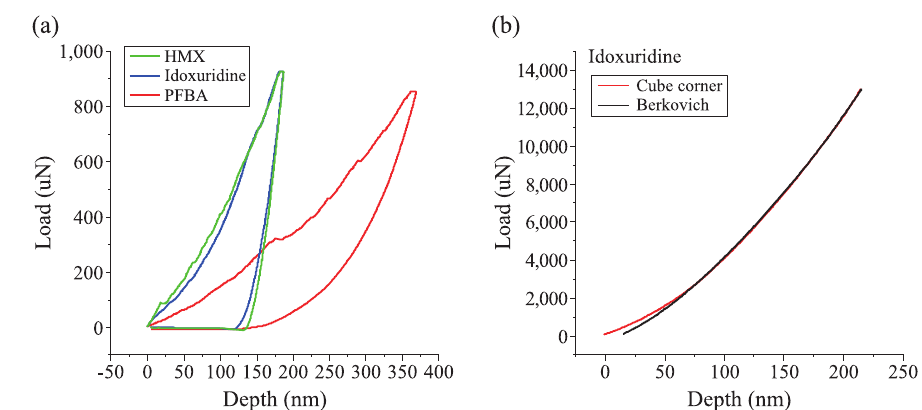
Fig. 8a Force-displacement curves and Fig. 8b . Unloading profiles Reprinted with permission from Ref. Burch A. et al., 2017a. Copyright